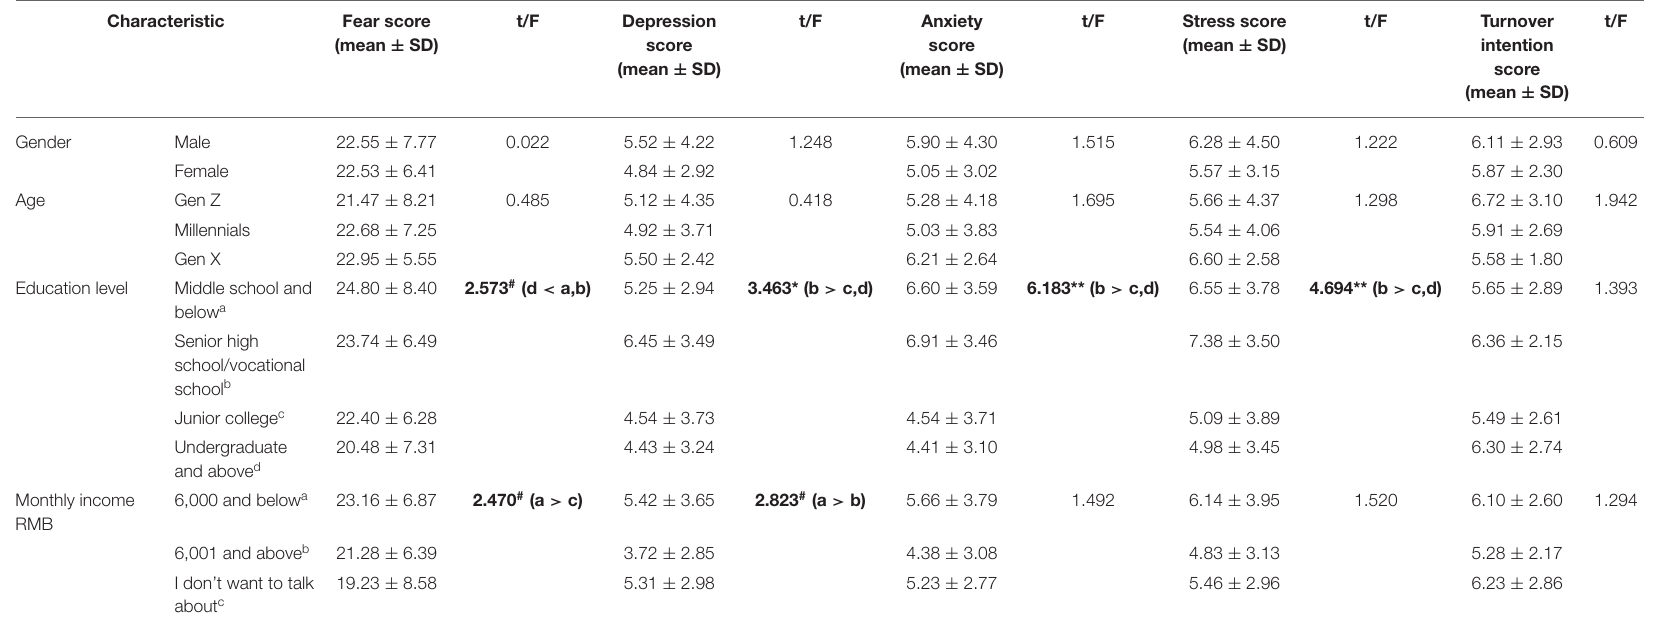
TABLE 2 | Correlations between key study